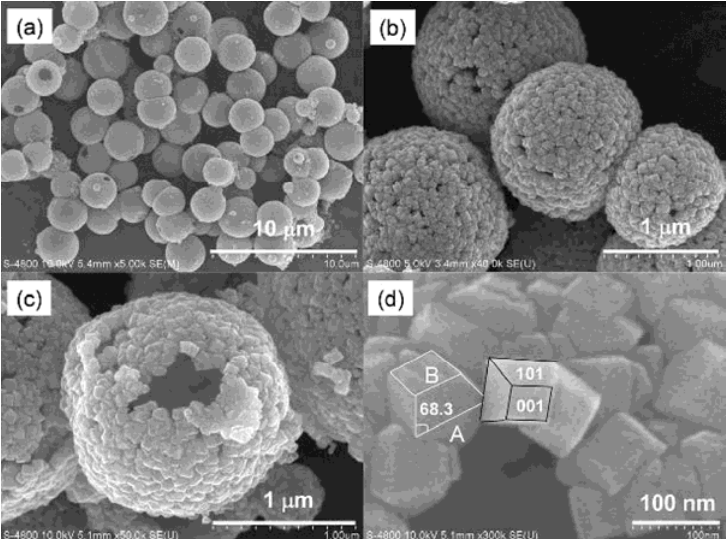
samples: ( a ) Overall view of TiO Figure 9. SEM images of the fluoride-mediated TiO 2 2 microspheres; ( b ) Image of a few microspheres showing their unique structure consisting nanoparticles; ( c ) A single microsphere showing its hollow nature; ( d ) A of primary TiO 2 portion of the microsphere shell composed of nanosized polyhedra with exposed {001} facets. Reprinted with permission from ref. [62]. Copyright 2010 American Chemical